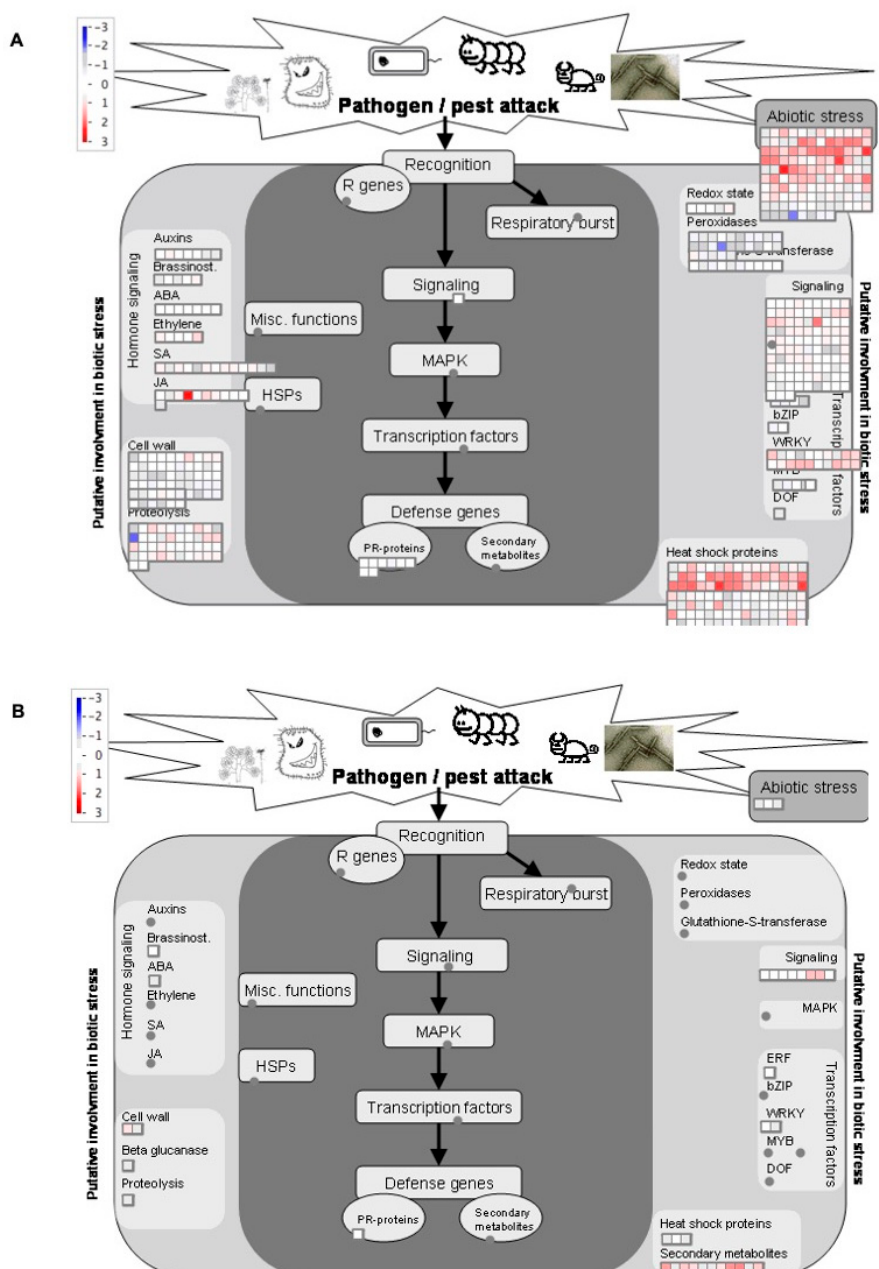
Figure 3. Overview of DEGs involved in response to wheat curl mite in the resistant ( A ) and suscep- tible ( B ) wheat varieties as visualized by MapMan. The colored boxes represent log10-transformed fold changes. The red color indicates increased expression in response to wheat curl mites, while the blue color indicates a decrease in expression.